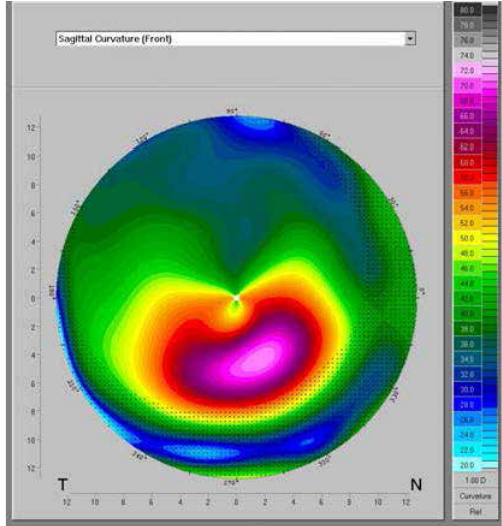
Figure 1 . A Pentacam image is shown indicating an inferiorly located cone.